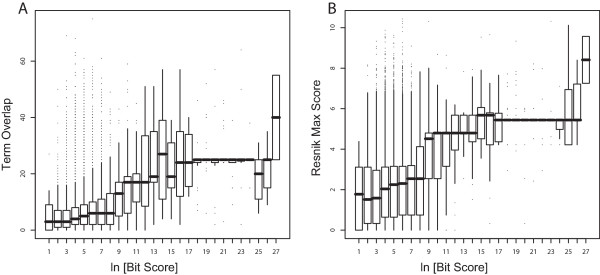
Comparing sequence and semantic similarity. A BLAST sequence analysis was performed to calculate a sequence similarity score for each gene pair in the 100 k set for which sequence data was available. Of those gene pairs we considered only the 53,264 which obtained a score greater than zero. Pairs were binned by bit score and the average in each bin plotted against (A) TO scores and (B) Resnik-max scores. Thick horizontal lines indicate medians, boxes indicate interquartile ranges, and whiskers are drawn at 1.5 times the quartile, or the maximum (whichever is closer to the median).